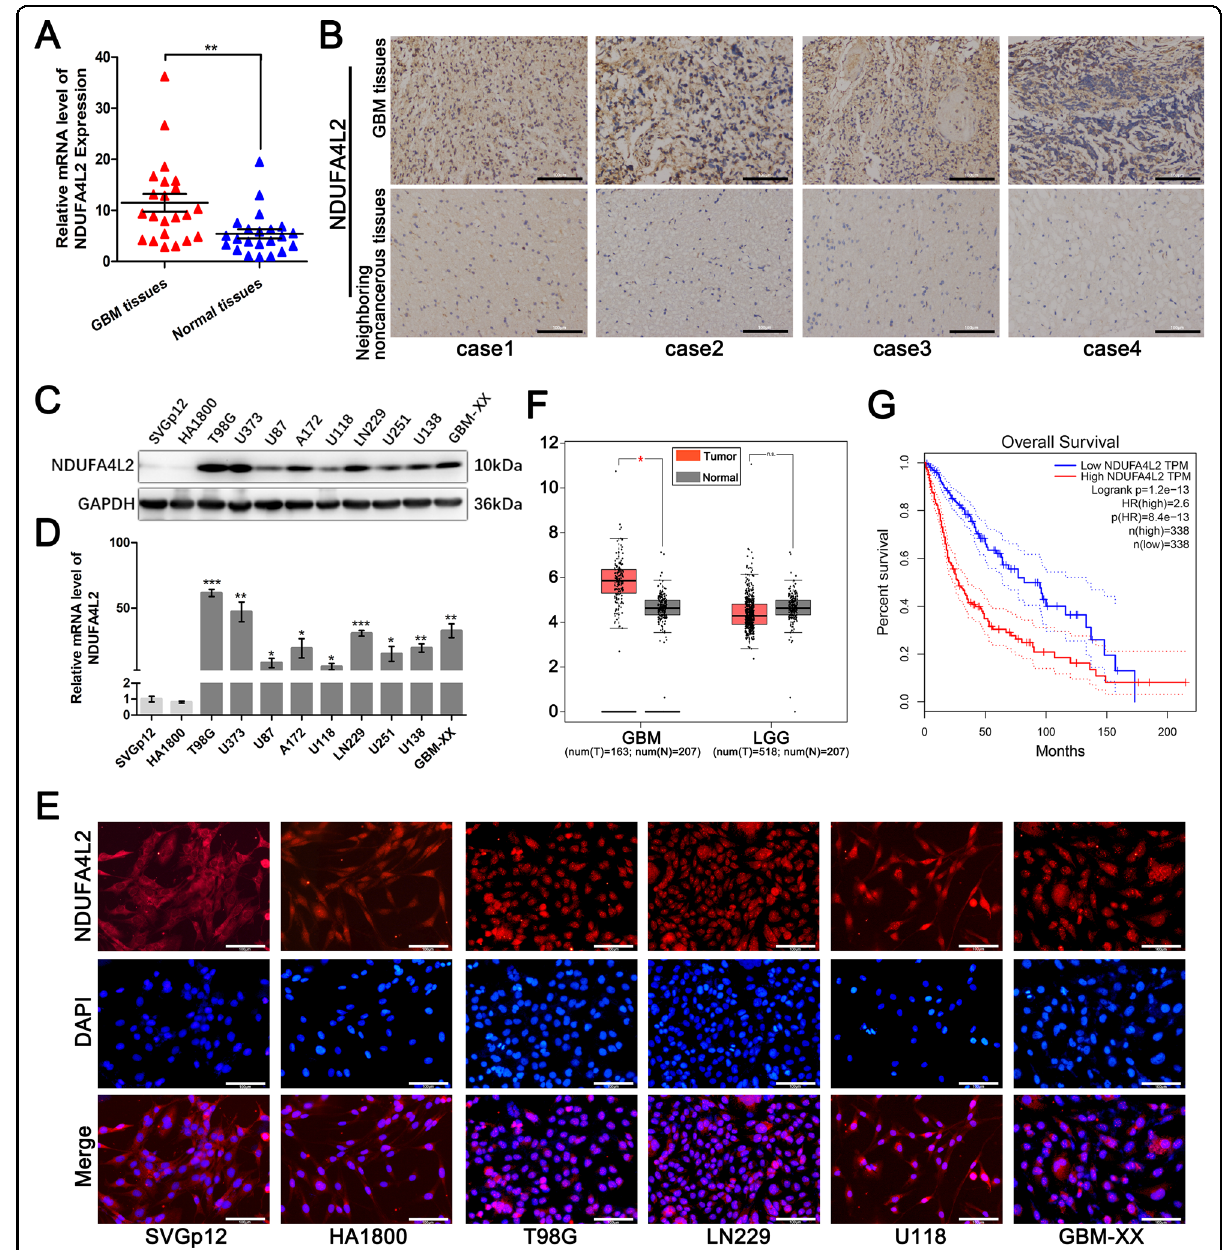
Fig. 1 NDUFA4L2 expression is elevated in glioblastoma (GBM) and is clinically signi fi cant. A Relative expression of NDUFA4L2 in GBM ( n = 22) and normal brain ( n = 22) tissues was detected by qRT-PCR. Relative expression of NDUFA4L2 was normalized to ACTIN. B NDUFA4L2 expression in GBM and neighboring non-cancerous tissues was determined by immunohistochemical staining. C , D Expression levels of NDUFA4L2 in GBM cell lines (T98G, U373, U87, A172, U118, LN229, U251, U138, and GBM-XX) and normal human brain astroglia cell lines SVGp12 and HA1800 were determined by western blotting and qRT-PCR. Relative expression levels of NDUFA4L2 were normalized to ACTIN in qRT-PCR. E NDUFA4L2 expression levels in GBM and normal human brain astroglia cell lines were measured by immuno fl uorescence assay. F Relative expression levels of NDUFA4L2 in clinical GBM ( n = 163) and normal brain ( n = 207) tissues were analyzed in TCGA and GTEx data. G Based on TCGA data, the Kaplan – Meier method with log-rank test was used to analyze the overall survival curves of patients with glioma in high and low NDUFA4L2 expression groups ( n = 338, log-rank = 2.6, p < 0.001). Means ± standard deviations (SDs) of triplicate experiments are plotted. * p < 0.05, ** p < 0.01, *** p < 0.001, n.s. not statistically signi fi